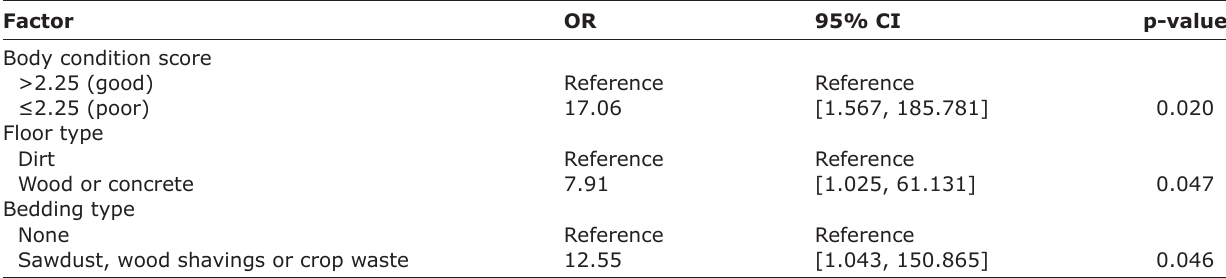
Table-4: Final multivariable logistic regression model of calf- and pen-level factors associated with dirtiness of 39 calves on 28 smallholder dairy farms in Kenya in